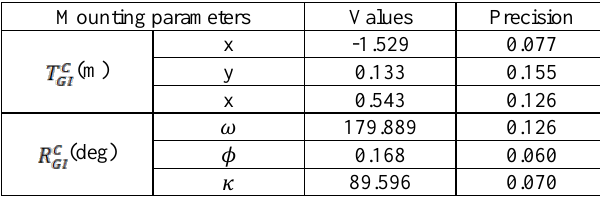
Table 4. Estimated system mounting parameters and their precision